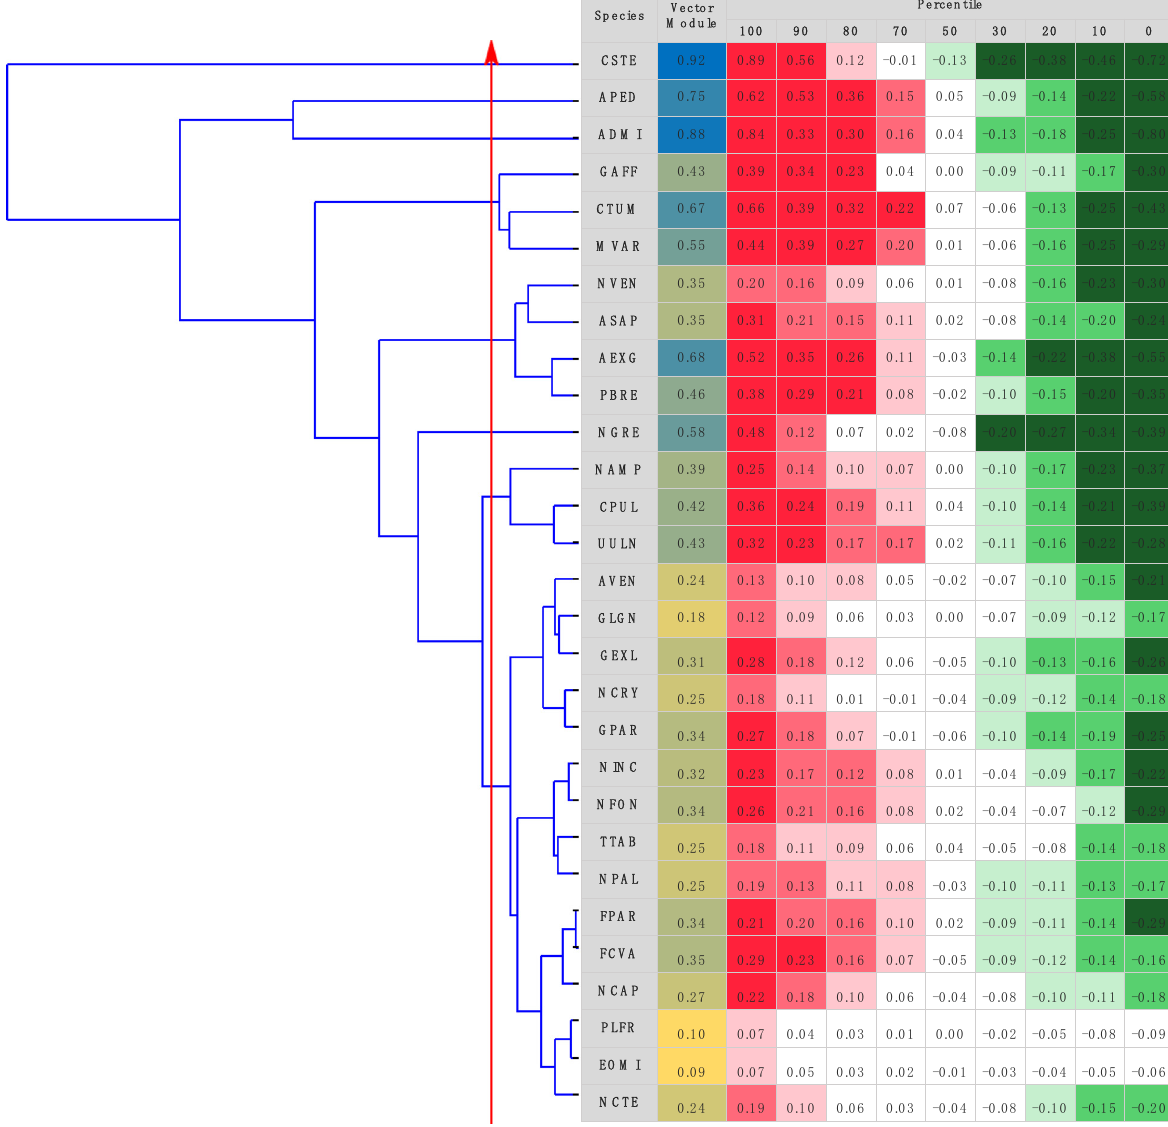
Figure 3. Percentiles of the scalar projections, and the Raman module for the integrated importance of the Raman variables over each species were calculated from the six significant components identified by the partial least squares regression discriminant analysis (PLS-DA). Red arrow—Linkage distance cut-off for the determination of the groups in the cluster analysis. High positive (red) and high negative (green) scalar projections indicate taxa showing high positive and negative covariances with the Raman variables, respectively. For the Raman module, darker blues represent the highest importance and lighter yellows represent the lowest importance. The cluster analysis was done on the Y loadings obtained from the PLS-DA. Species are Cyclotella stelligera (CSTE), A mphora pediculus (APED), Achnanthidium minutissimum (ADMI), Gomphonema affine (GAFF), Cymbella tumida (CTUM), Melosira varians (MVAR), Navicula veneta (NVEN), Achnanthidium saprophilum (ASAP), Achnanthidium exiguum (AEXG), Pseudostaurosira brevistriata (PBRE), Navicula gregaria (NGRE), Nitzschia amphibia (NAMP), Ctenophora pulchella (CPUL), Ulnaria ulna (UULN), Amphora veneta (AVEN), Gomphonema lagenula (GLGN), Gomphonema exilissimum (GEXL), Navicula cryptocephala (NCRY), Gomphonema parvulum (GPAR), Nitzschia inconspicua (NINC), Nitzschia fonticola (NFON), Tabularia tabulata (TTAB), Nitzschia palea (NPAL), Fragilaria pararumpens (FPAR), Fragilaria vaucheriae (FCVA), Nitzschia subconstricta (NSBC), Planothidium frequentissimum (PLFR), Eolimna minima (EOMI), Navicula cryptotenella (NCTE).